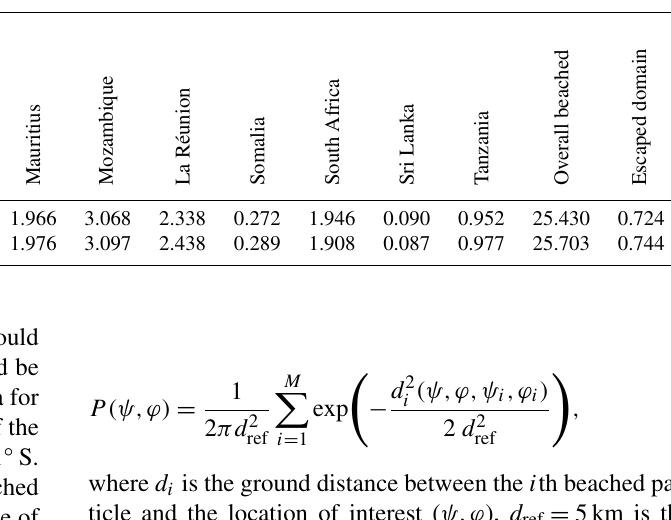
Figure 11. Expected along-shore concentration of beached MH370 fragments from the hypothetical origin no. 23 to be found by the end of 2016. Table 3. Sensitivity of the percentages of particles washed ashore by the end of 2016 to the number of particles in ensembles (origin no.